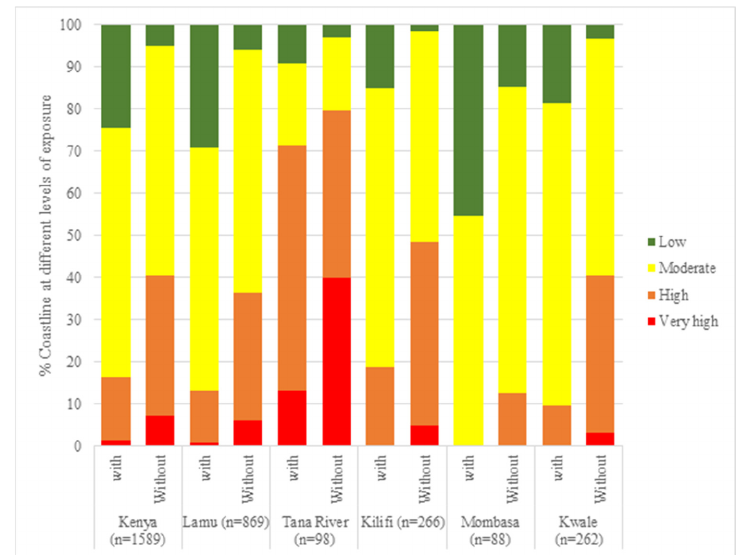
Figure 2. Proportion of country and counties coastline length at the different relative levels of exposure (no points of very low exposure were recorded by the model).